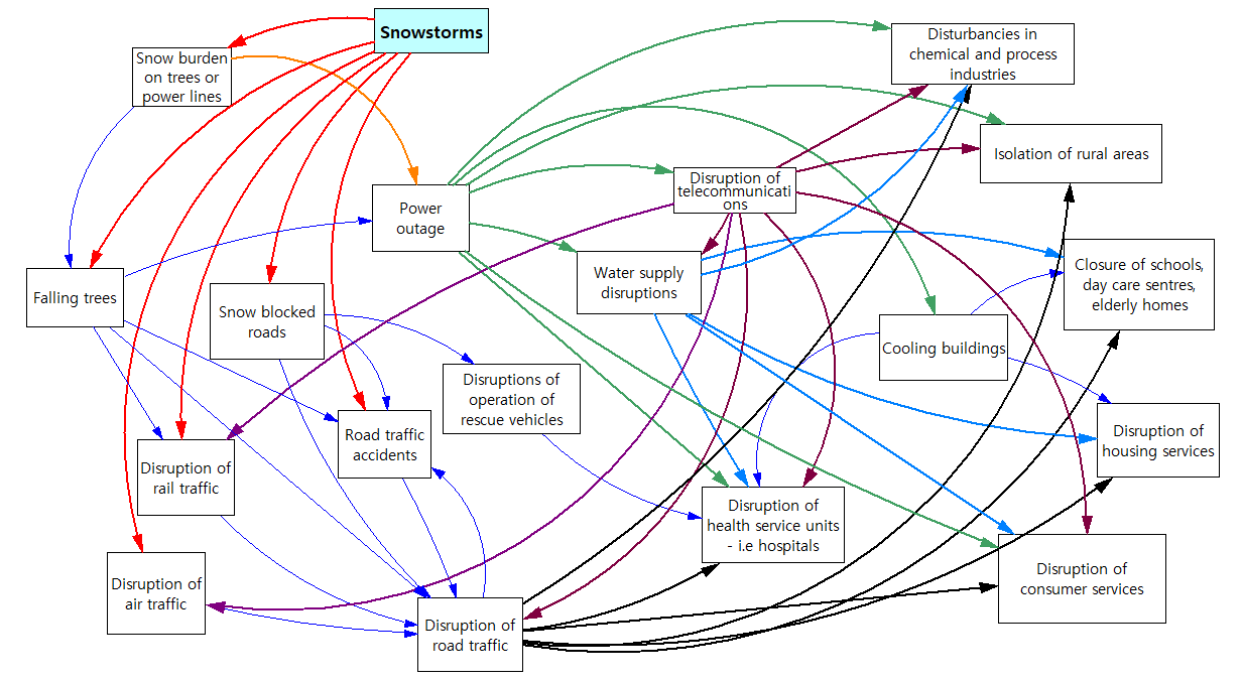
Figure 5. The causal loop diagram regarding the effects of a snowstorm in Finland.